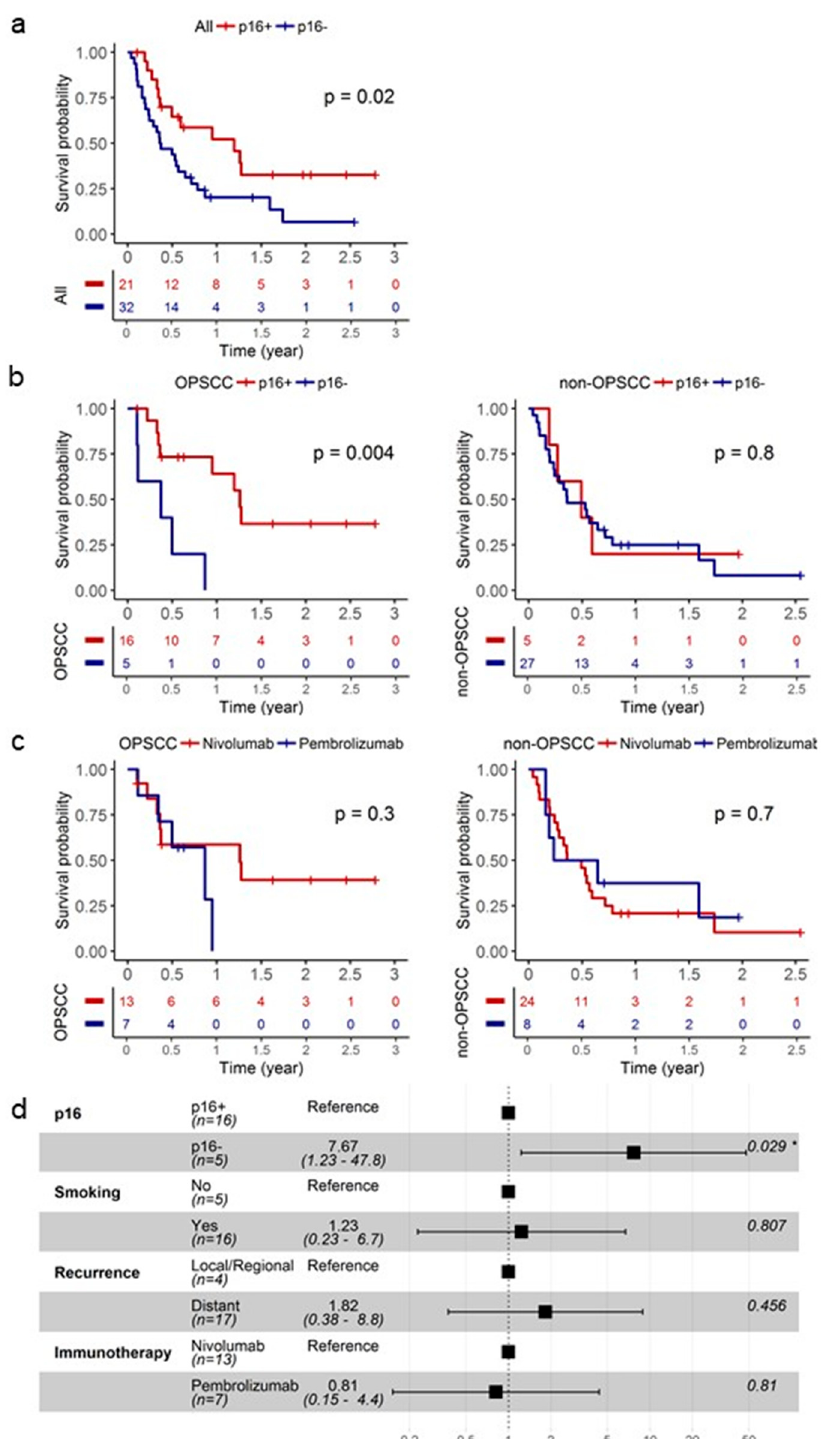
Figure 2. p16+ is an independent prognostic biomarker in immunotherapy-treated R/M OPSCC patients. ( a ) KM plot stratified based on p16 status for the entire cohort. ( b ) KM plot stratified based on p16 status for the oropharynx and non-oropharynx SCC cohorts. ( c ) KM plot stratified based on anti-PD-1 immunotherapy choice for the oropharynx and non-oropharynx SCC cohorts. ( d ) Multivariate model for the oropharynx SCC cohort presented as a forest plot. * p <